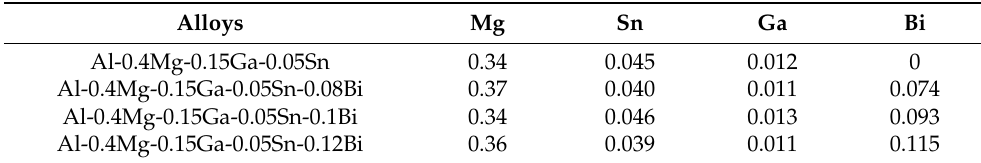
Table 1. Chemical composition of experimental alloys (wt.%). Alloys